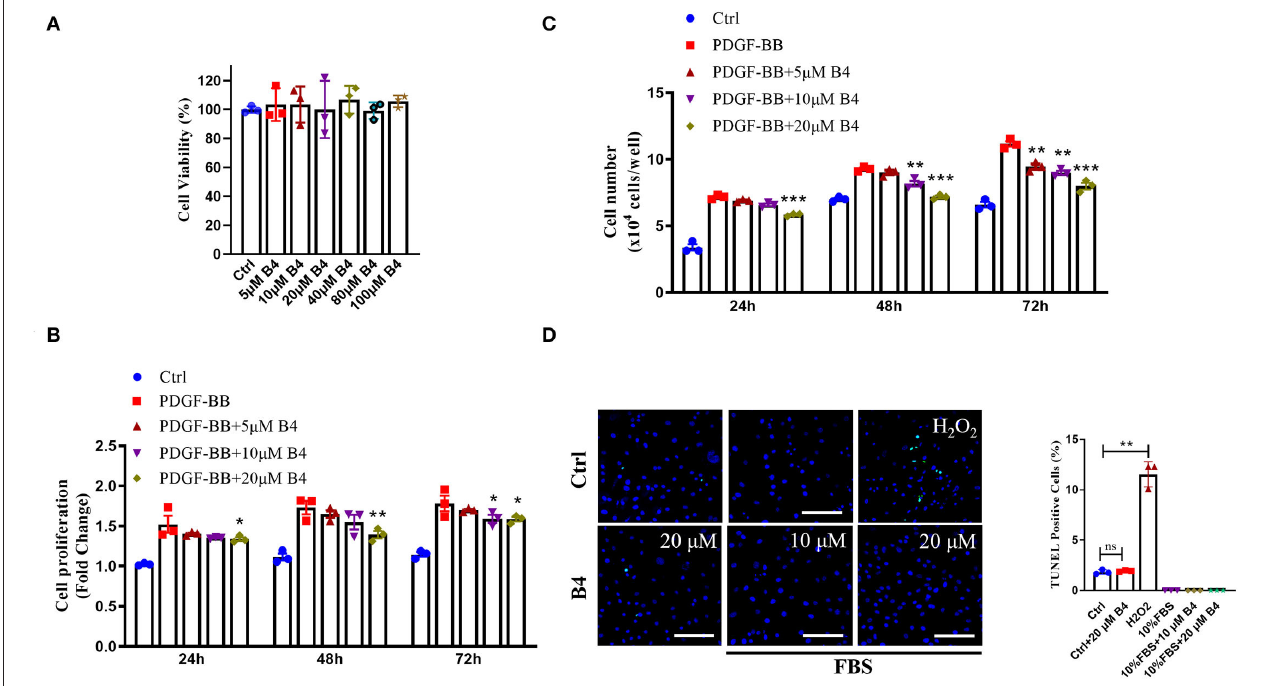
FIGURE 2 | B4 inhibits MVSMCs proliferation but not cell viability or apoptosis. (A) Cell viability was measured by MTT assays. PDGF-BB-deprived MVSMCs were pretreated with 5–100 µ M of B4 for 24h and incubated with/without PDGF-BB in the absence or presence of B4 for the indicated times. Cell proliferation was detected by (B) MTT assays. (C) Direct cell counting. (D) MVSMC apoptosis was measured by TUNEL staining. Data shown are means ± SEM. N = 3. * P < 0.05; ** P < 0.01; *** P < 0.001; compared with PDGF-BB control group. Scale bar, 100 µ m. All experiments were repeated at least for three